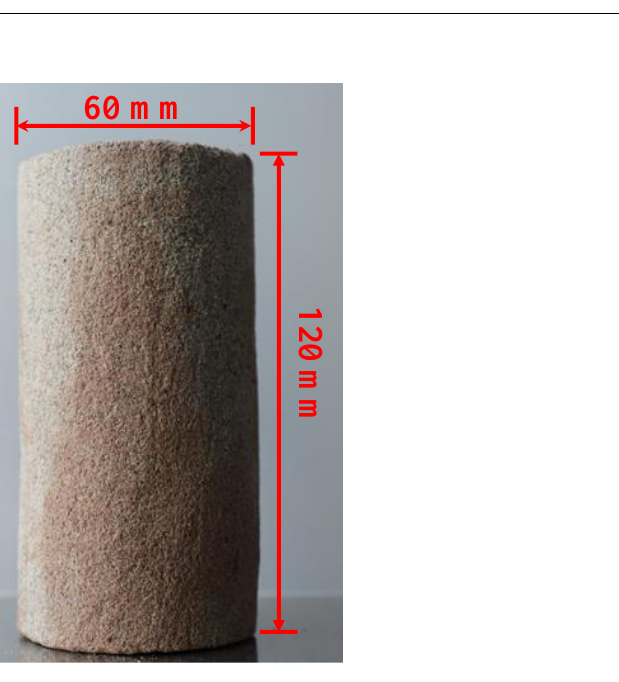
Figure 13. Dimensions of Pisha sandstone specimens. Table 3. The average values of the physical properties of the initial Pisha sandstone specimens. Diameter (mm) Height (mm) Mass